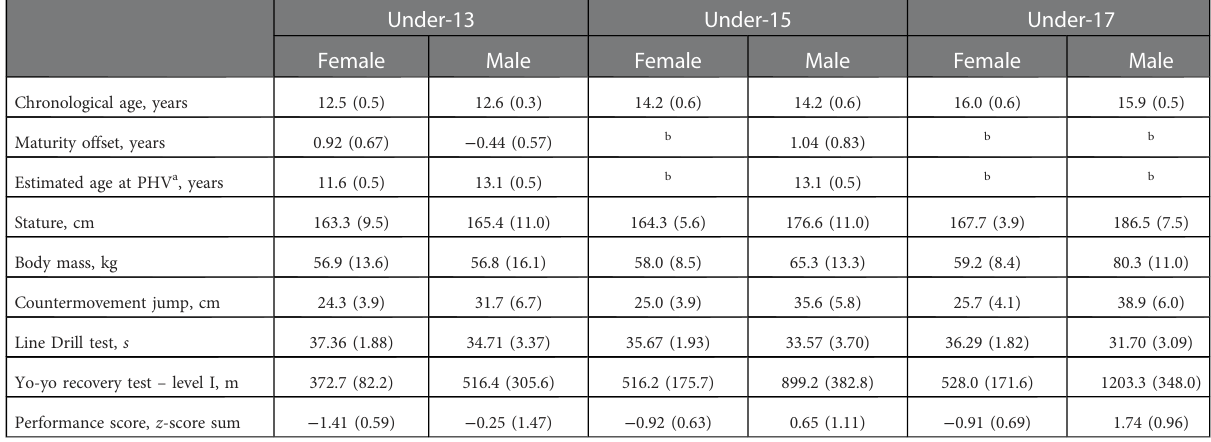
TABLE 1 Descriptive statistics of the sample at pre-season by age group and sex.